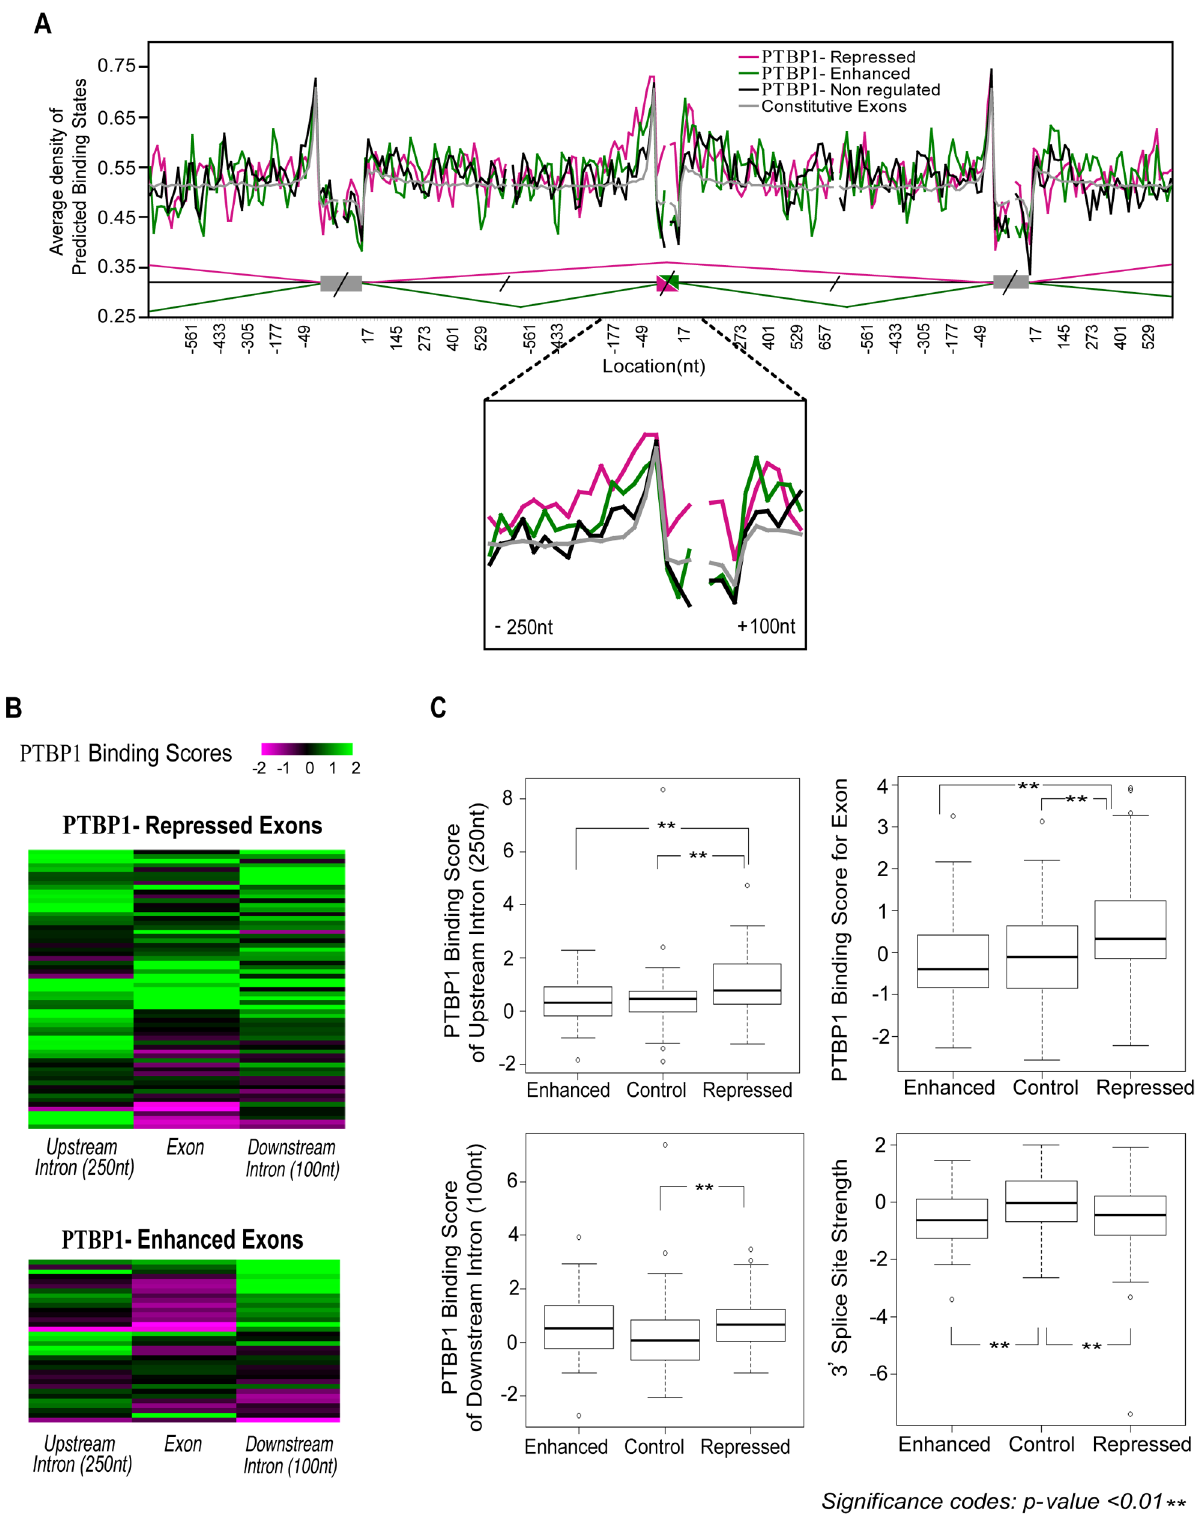
Figure 3. Sequence characteristics of PTBP1-dependent alternatively spliced exons. A . An RNA map shows enrichment of predicted PTBP1 binding sites near PTBP1-dependent exons. The Y-axis plots average density of predicted PTBP1 binding states within a 24 nt window; the length of overlap between two adjacent windows was 8 nt. B . To assess PTBP1 binding signatures of individual exons, known PTBP1 regulated exons were clustered by their PTBP1 binding score profiles and visualized as heat maps. These heat maps indicate wide variation in the positions of PTBP1 binding sites between individual exons. C . Four sequence features including the PTBP1 binding scores and 3 9 splice site strength show statistically significant differences between regulated and control exon groups (one-tailed Student’s t-tests). doi:10.1371/journal.pcbi.1003442.g003 PLOS Computational Biology | www.ploscompbiol.org 6 January 2014 | Volume 10 | Issue 1 |